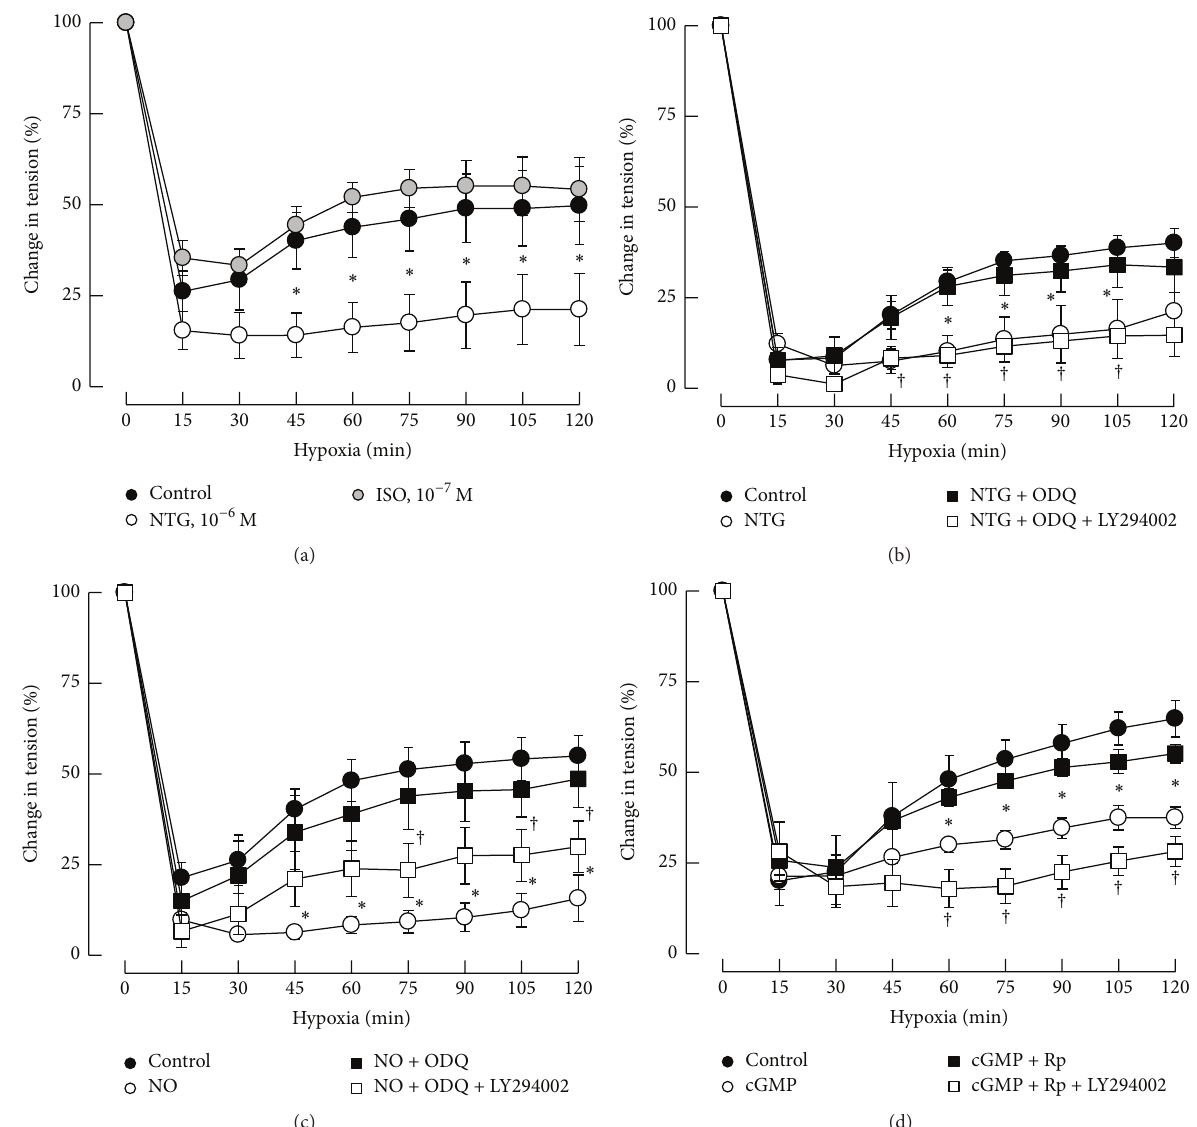
Figure 1: Effects of NTG, ISO, DETA NONOate, and cGMP on hypoxic vasoconstriction. The continuous contraction caused by hypoxia in porcine coronary arteries was prevented by NTG (10 −6 M), but not by isoproterenol (ISO, 10 −7 M; (a)). The prevention of the hypoxic vasoconstriction caused by NTG (10 −6 M; (b)), DETA NONOate (NO, 10 −4 M; (c)), and 8-Br-cGMP (cGMP, 10 −4 M; (d)) was recovered by ODQ (3 × 10 −5 M, a specific inhibitor of sGC; (b) and (c)) and Rp-Br-PET-cGMPS (PKG-I; 3 × 10 −5 M; (d)). The restored hypoxic contraction of porcine coronary arteries by ODQ or Rp-Br-PET-cGMPS was reversed by LY294002 (10 −5 M, a specific inhibitor of PI3K; (b), (c), and (d)). Data are means ± SEM; 𝑛 = 4 –6 for each group. ∗ significantly different between the control group and treatment group with NTG, DETA NONOate, or 8-Br-cGMP ( 𝑃 < 0.05 ); † significantly different between the group with LY294002 and the group without LY294002 ( 𝑃 < 0.05